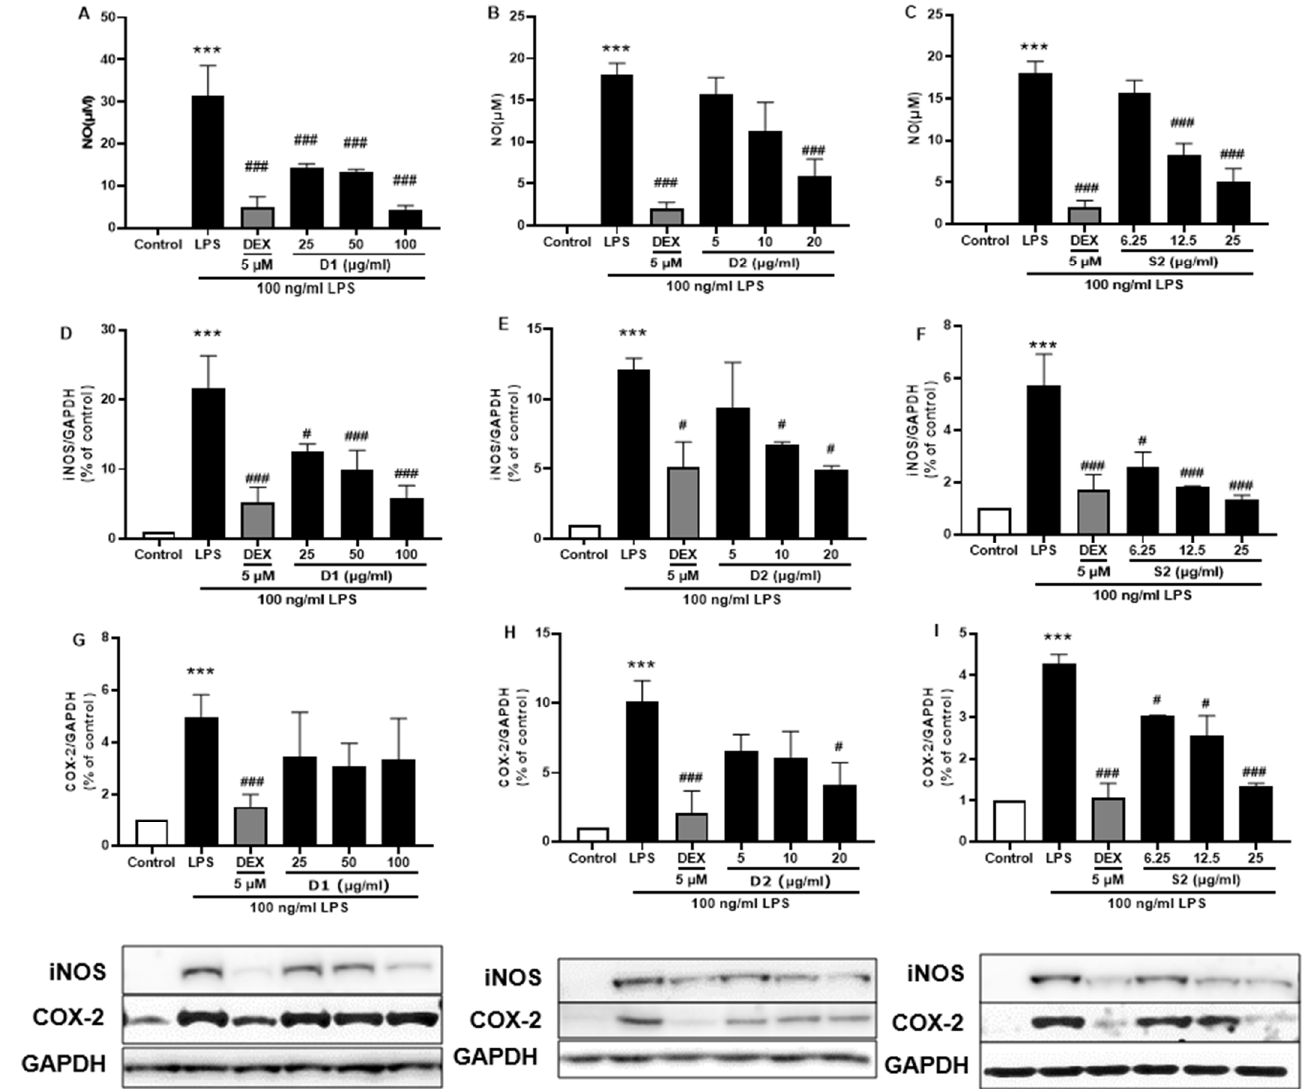
Figure 7. Effect of the P. ginseng extracts on nitric oxide (NO) and iNOS/COX ‐ 2 production in LPS ‐ stimulated BV ‐ 2 cells. ( A – C ) NO levels in the cell supernatant were measured by Griess reagent colorimetric reaction. Respective Western blots presenting the expression level of the ( D – F ) iNOS & ( G – I ) COX ‐ 2. Experimental results were presented as mean ± SEM. ***: p < 0.001, the significant difference compared with the control. Compared with LPS group, #: p < 0.01, ###: p < 0.001 ((one ‐ way ANOVA followed by Dunnett’s multiple comparisons).